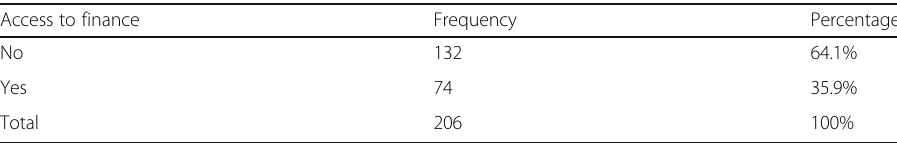
Table 4 Access to finance Access to